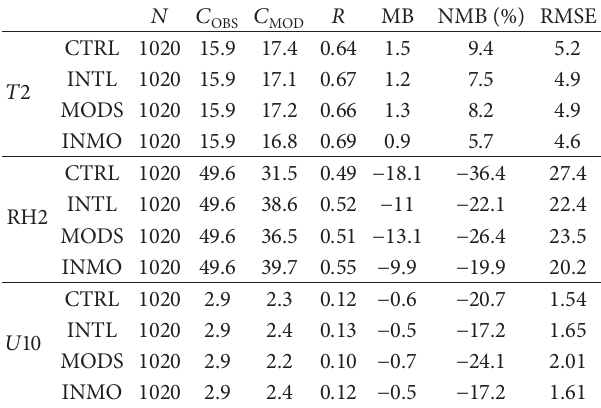
Table 2: Statistics of 𝑇 2 ( ∘ C), RH2 (%), and 𝑈 10 (m/s) between the observation and model